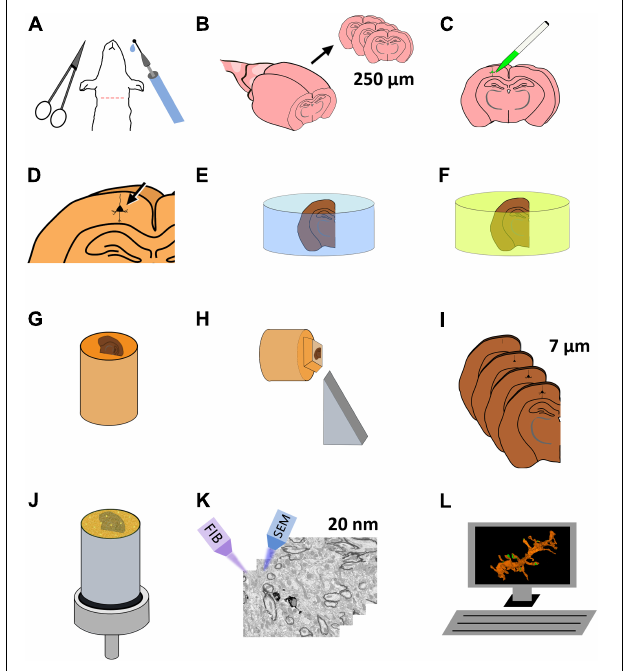
FIGURE 1 | Schematic representation of the protocol for the preparation of brain tissue for single-neuron labeling and FIB-SEM imaging. (A) Perfusion fixation of experimental animals. (B) Vibratome sectioning in slices (250 µ m thick). (C) Intracellular injection of HRP and LY. (D) Development of HRP. (E) Postfixation and osmication. (F) En bloc staining. (G) The flat embedded section is glued onto a blank Araldite block. (H) Re-sectioning of the sample. (I) A series of 7 µ m sections is obtained. (J) One of the 7 µ m sections is selected and mounted for FIB-SEM. To facilitate charge dissipation, the block (except for the upper surface) is painted with conductive silver paint, and then sputter-covered with gold-palladium. (K) FIB-SEM serial milling and imaging. (L) Three-dimensional reconstruction and image